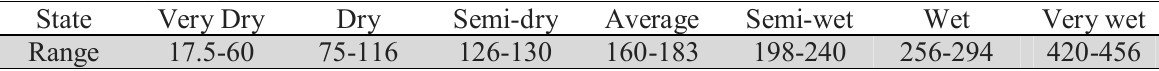
The summary of input flow in terms of cubic